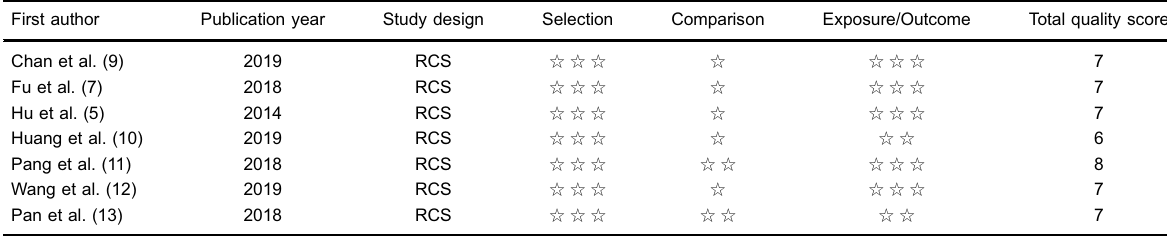
Figure 1. Literature screening process and results. Table 1. Newcastle-Ottawa scale quality score of each